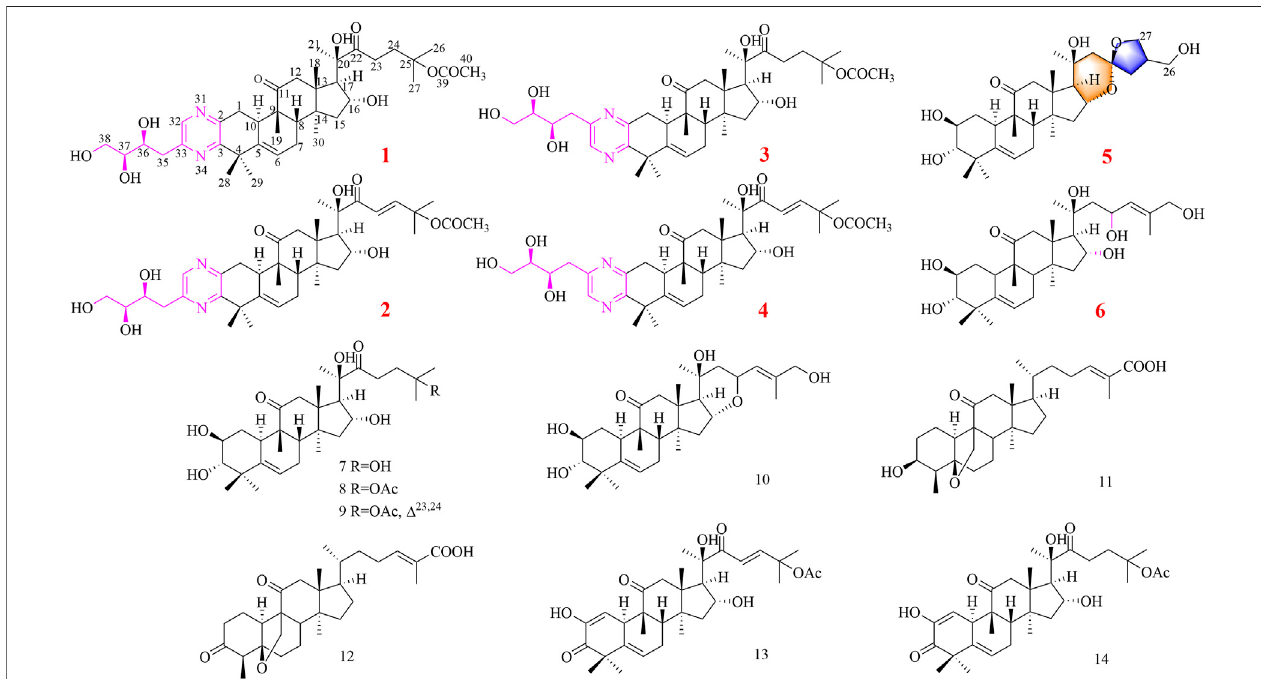
FIGURE 1 | Compounds 1 – 14 isolated from S. grosvenorii